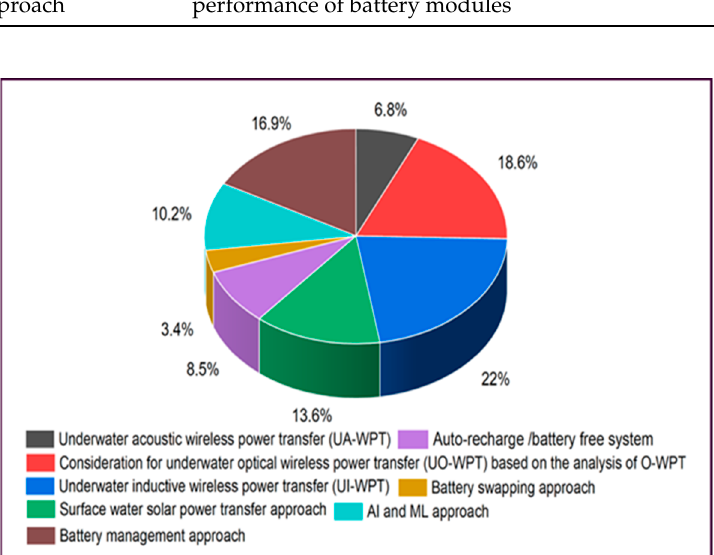
Figure 10 . Analysis of various energy optimization techniques in UIoT networks. Figure 10. Analysis of various energy optimization techniques in UIoT